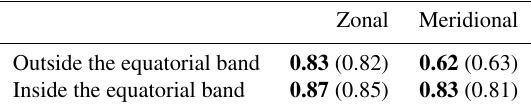
Table 3. Taylor skill scores for the comparison of the geostrophic currents computed from altimetry or measured by drifters. Results obtained with DT2014 (2010) products are in bold (parentheses).